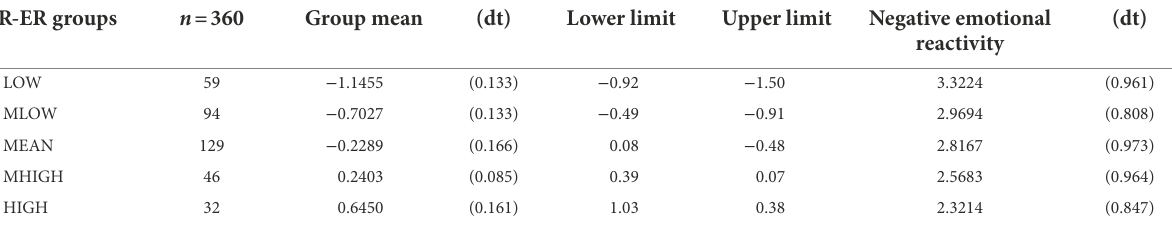
TABLE 12 Descriptive statistics for the groups formed ( n = 360).